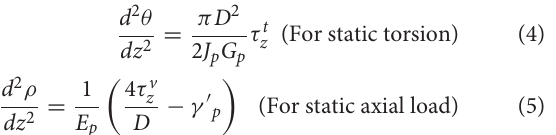
Boundary Element